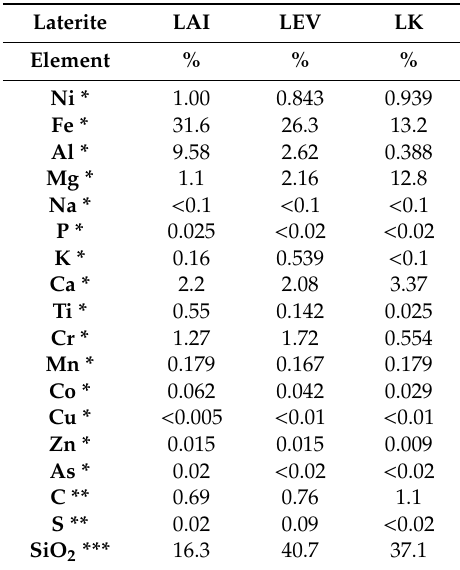
Table 1. Chemical composition of the laterite